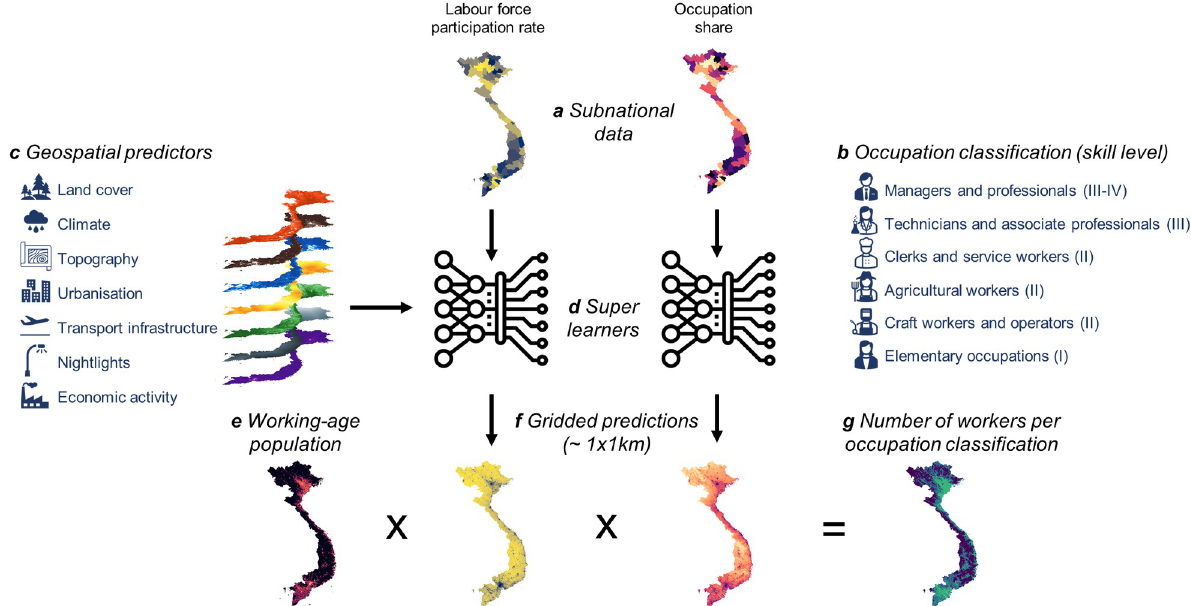
Fig 1. Overview of the analytical approach. (a) Subnational statistics on the labor force participation rate and occupation shares for (b) six occupation classes and (c) a large number of geospatial predictors were combined to train (d) super learner models. (e) Spatial information on the working-age population was combined with (f) resulting gridded predictions to produce (g) maps of the number of workers per occupation category. This figure has been designed using resources from Flaticon.com. Maps produced using data from [30] and calculations by authors, see text.